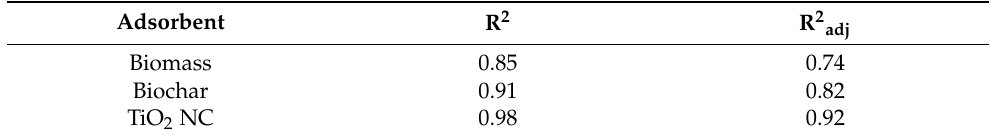
Table 5. R 2 and R 2 adj values of biomass, biochar and TiO 2 NC.